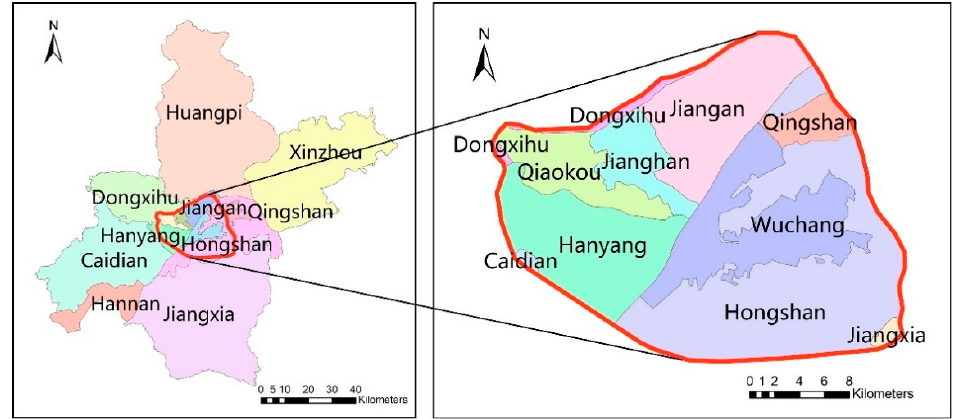
Figure 5. The case study area: Third Ring Road of Wuhan, China.